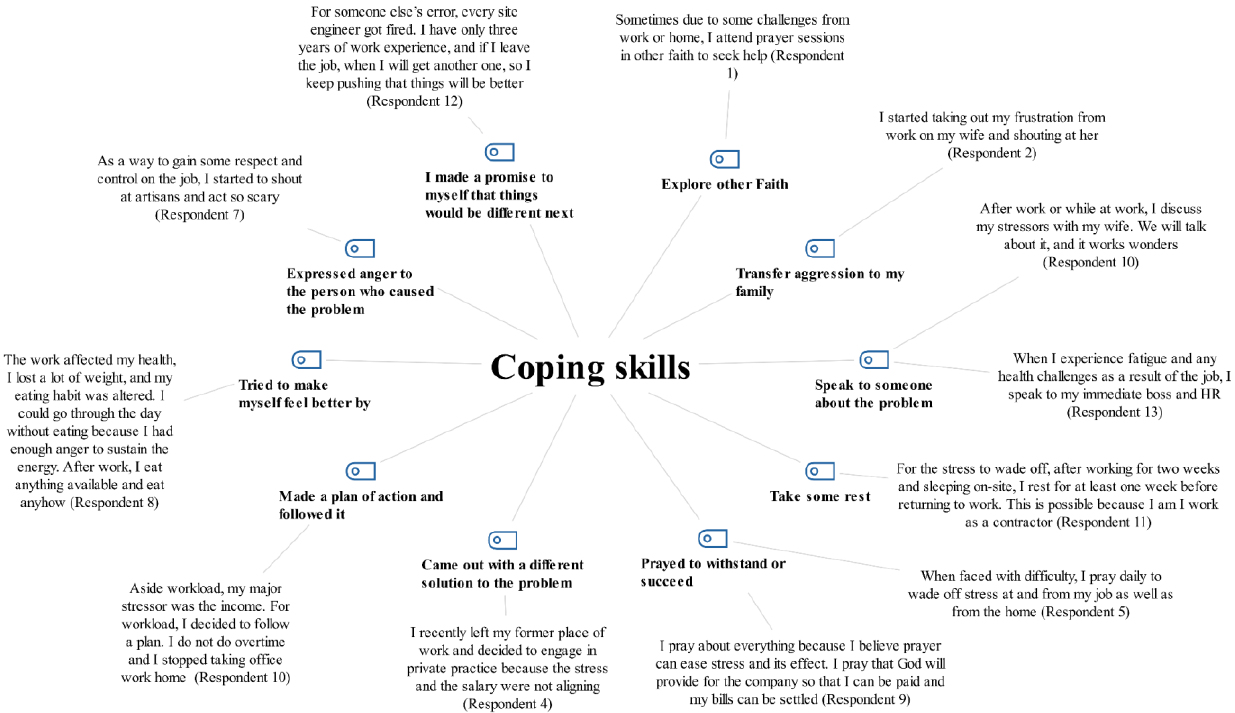
Figure 2. Coping skills employed by supervisors and some excerpts based on thematic analysis. Using univariate logistic regression, it was gathered that PFC skills of positive reappraisal (OR = 0.17), planful problem-solving (OR = 0.09), and seeking social support (OR = 0.29) were significant predictors for reduced odds of anxiety symptoms (see Table 4). This indicates that supervisors who employ the PFC skills were only 0.09 times, 0.17 times, and 0.29 times likely to experience anxiety. As indicated in Table 4, accepting responsibility (OR = 2.28) and avoidance coping skills (OR = 2.69; OR = 4.06) were associated with elevated odds of anxiety and depression symptoms. Supervisors who employ emotion-focused coping strategies, especially avoidance skills , were 2.69 times and 4.06 times more likely to experience depression and anxiety symptoms, respectively, while those who employ accepting responsibility skills were 2.28 times more likely to experience anxiety. This result indicates that hypothesis H1 is supported. This implies that skills related to PFC are negatively associated with mental ill-health symptoms, while EFC strategies are positively related to mental ill-health